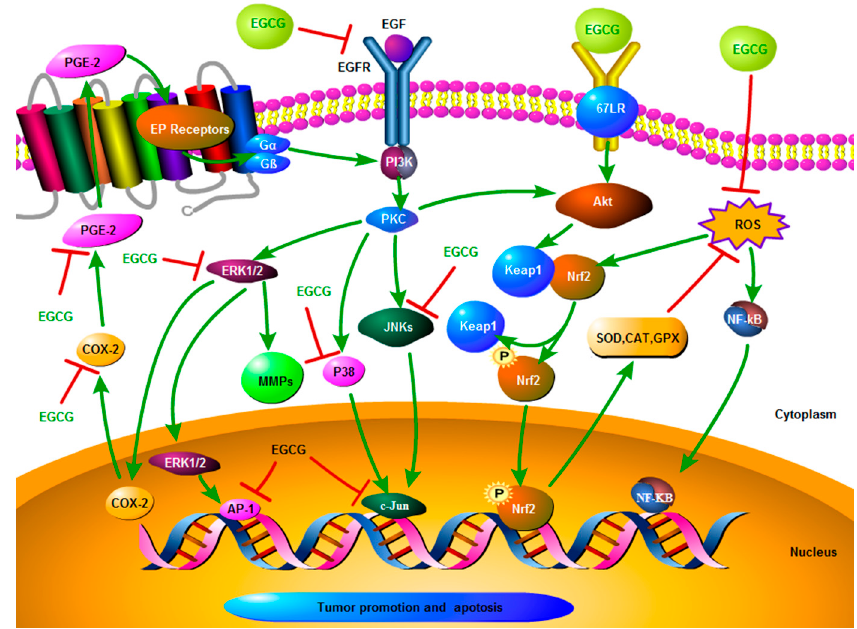
Figure 1. Possible mechanisms of EGCG on EC based on published literatures. Note : A red symbol” T” means “Inhibition”; a green arrow means “Activation”. Abbreviation: PKC: protein kinase C; PI3K, phosphatidylinositol 3-kinase; Akt, protein kinase B; SOD, Superoxide dismutase; CAT, catalase; GPX, glutathione peroxidases; EP, E-series of Prostaglandin; G α / β , G protein α / β ; Nrf2, nuclear related factor erythroid-derived 2; Keap1, Kelch like ECH associated protein 1; NF-kB, Nuclear factor kB.